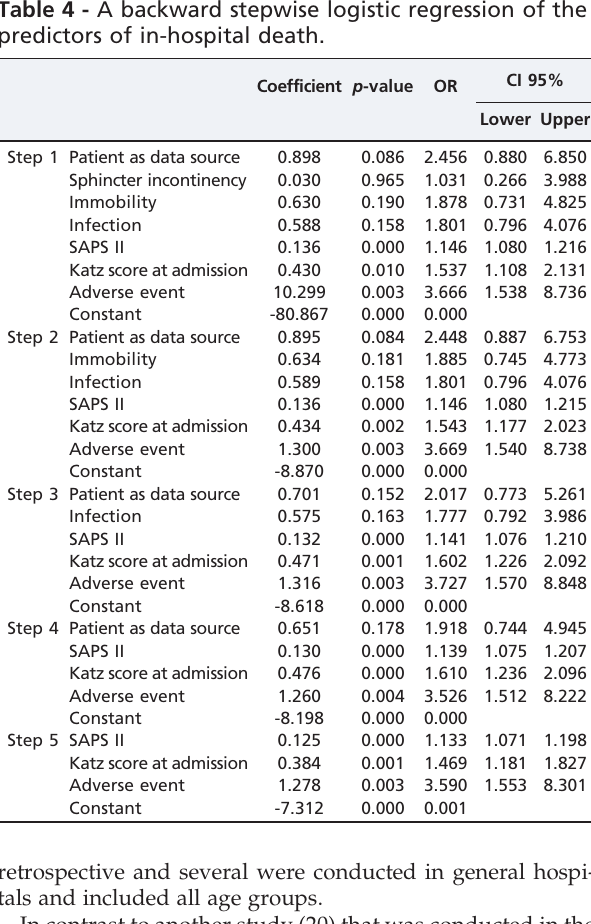
Table 4 - A backward stepwise logistic regression of the predictors of in-hospital death. Coefficient p -value OR CI 95%